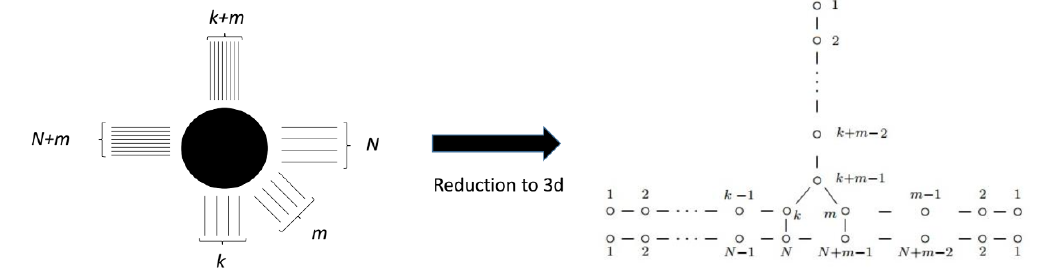
Figure 3 . We conjecture that reducing the 5d SCFT described by the brane system on the left leads to a 3d theory with a mirror dual given by the quiver on the